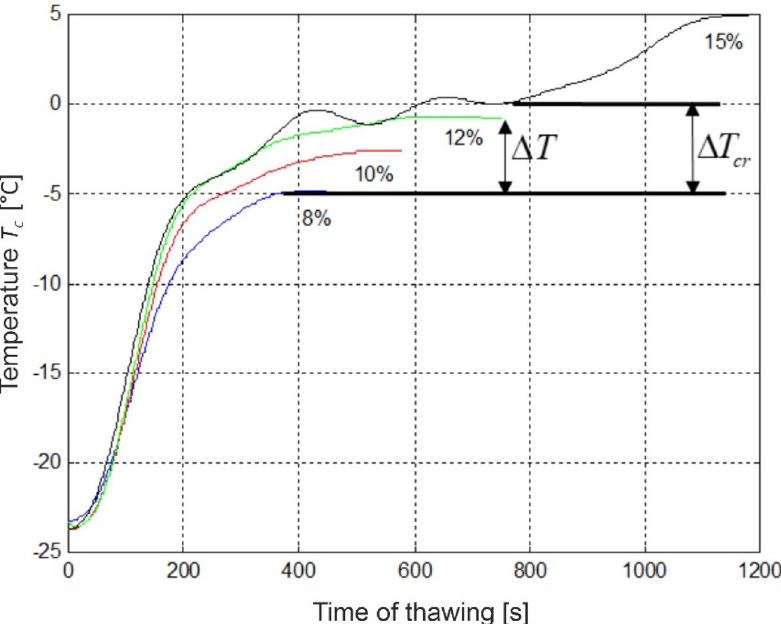
Figure 4. Comparative combination of temperature T c changes at the centre of a sample at the water vapour deposition stage, for 8%, 10%, 12%, and 15% of sublimation dehydration: ΔT the range of phase change occurring within meat during its defrosting for individual sublimation variants; ΔT cr the range of temperatures assumed as cryoscopic temperatures (from − 5 to 0 °C).